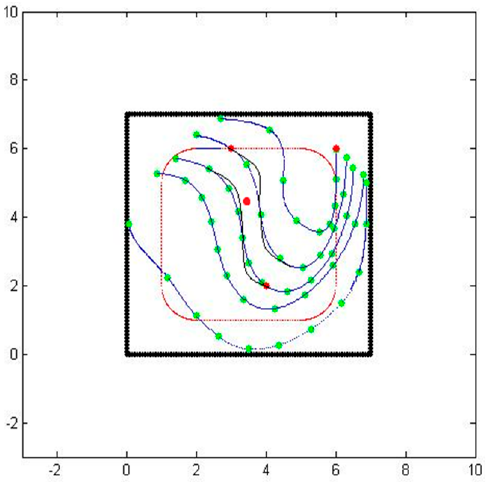
Figure 6. Updated air-borne particle paths going through three sensors and an additional sensor.